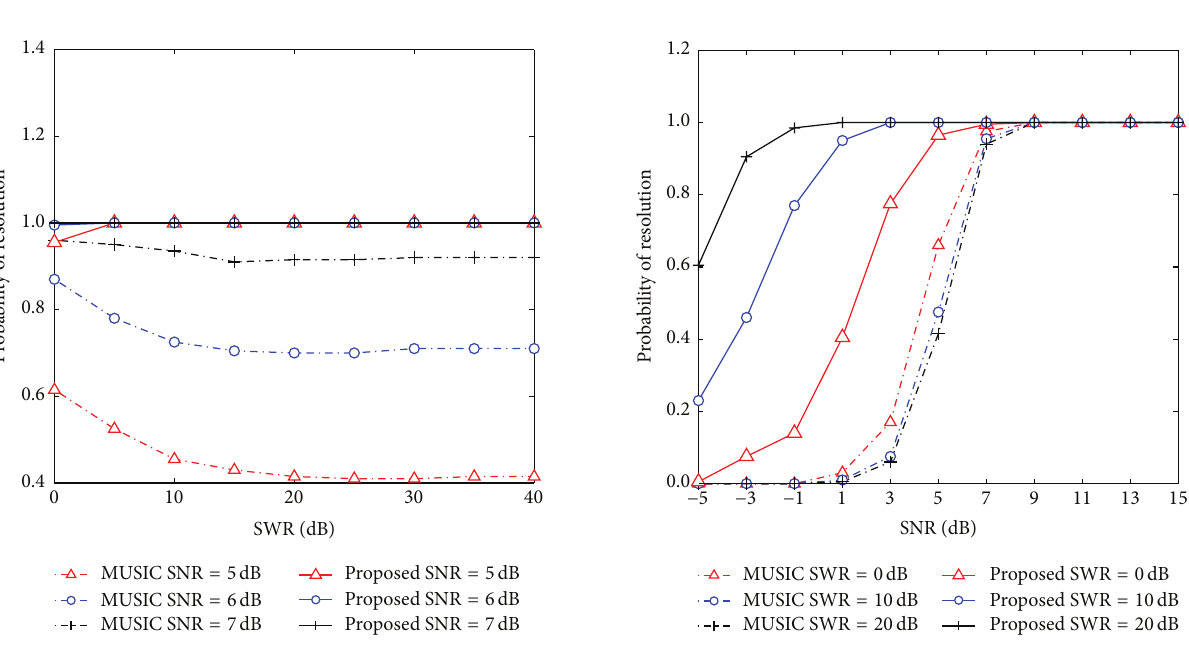
Figure 3: Resolution probability against the SWR, where the strong source is located at (𝜃 1 , 𝛾 1 ) = (3 ∘ , 30 ∘ ) and the weak source is located at (𝜃 2 , 𝛾 2 ) = (7 ∘ ,35 ∘ ) .